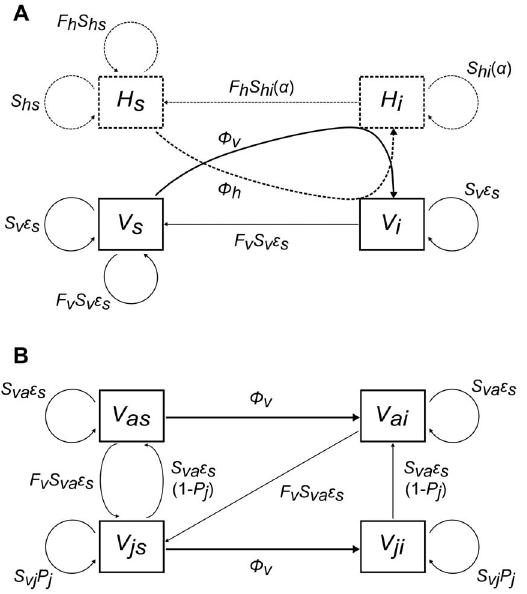
Figure 1. Schematic representation of the one-parasite-strain version of the model. Because vectors are divided into two stages (juvenile and adult), and that both stages can get and transmit the parasite, we present first a simplified vector-borne epidemiological model with only one stage for vectors (panel a) and then the vector life- cycle (panel b). Hosts are represented with dashed lines and vectors with solid lines (a) Susceptible hosts H s get infected through contacts with infected vectors V i with probability W h , and susceptible vectors V s through contacts with infected hosts H i with probability W v . Susceptible and infected vectors and hosts give birth to susceptible vectors and hosts. Infected host survival S hi is a function of parasite virulence a . Environmental stochasticity is applied to vector survival (only adults, see below) with intensity e s . (b) Susceptible and infected adult vectors V as and V ai give birth to susceptible juvenile vectors V js . Susceptible and infected juvenile vectors V js and V ji remain in the juvenile stage with probability P j and mature into adults with probability (1- P j ). Only adult survival S va is submitted to stochasticity with intensity e s . See text, Table 1, Appendix S1 in File S1 and Fig. S1 for further details.